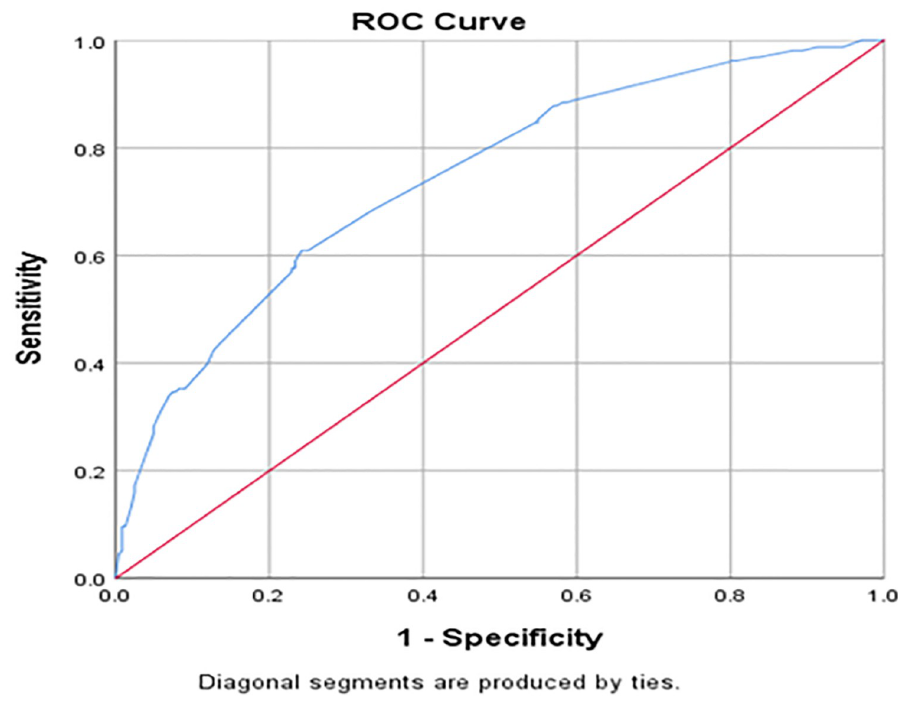
Fig 2. ROC curve graph showing model discrimination power towards delayed ART initiation among adults receiving ART at public health institutions in Bahir Dar city, Northwest Ethiopia, 2022.